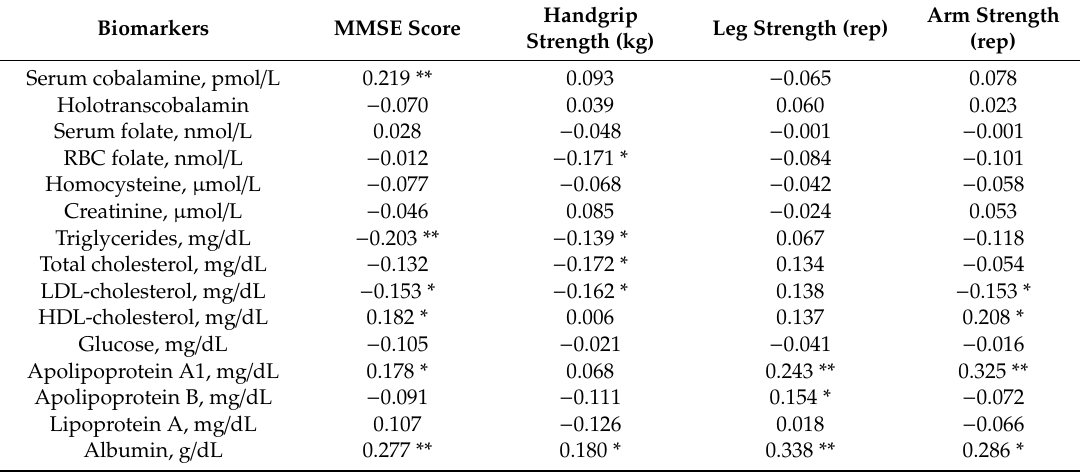
Table 2. Pearson’s correlation coe ffi cients ( p ) between biomarkers; cognitive and functional